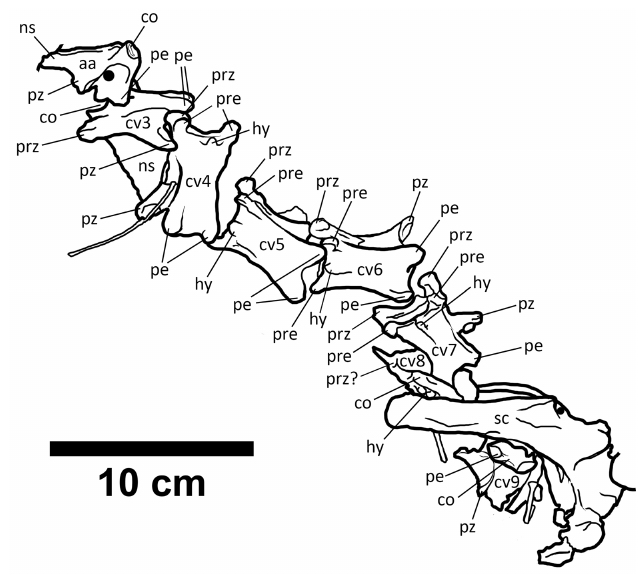
Figure 5. Cervical vertebrae of UALVP 24238. Abbreviations: aa, atlas-axis complex; co, cotyle; cv, cervical vertebra; hy, hypapophysis; ns, neural spine; pe, postexapo- physis; pre, preecapophysis; prz, prezygapophysis; pz,